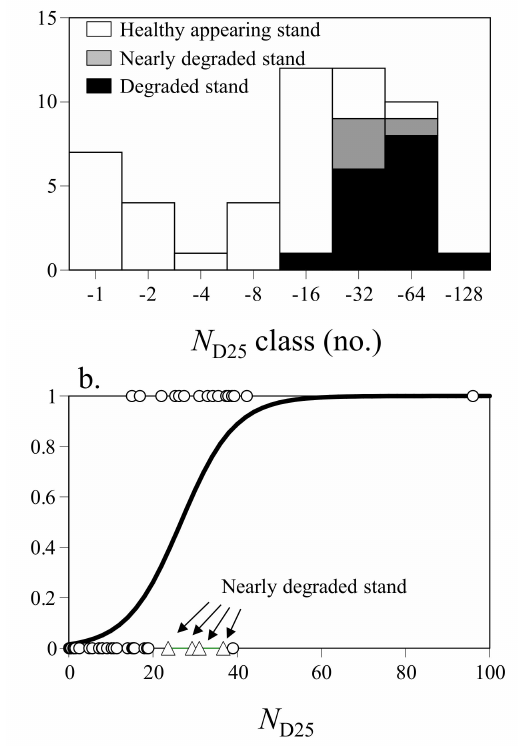
Figure 7. Stand density of each study plot with respect to year of establishment. stand; (cid:78) , nearly degraded stand; (cid:4) , degraded stand. *, Plot 12 was composed of slender trees that would be associated with relatively high density. associated with relatively high density. ⁑ , Plot 21 in which there were , Plot 21 in which there were many trees with little foliage in the crown.